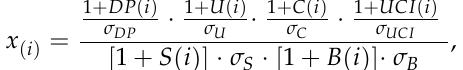
Figure 3. Construction of comprehensive grade model of Chinese fi r spatial structure